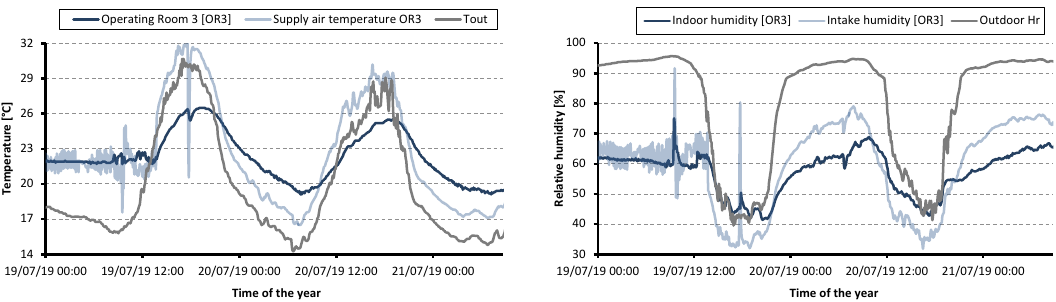
Figure 6. Temperature and humidity from OR3 during the first experimental data campaign.